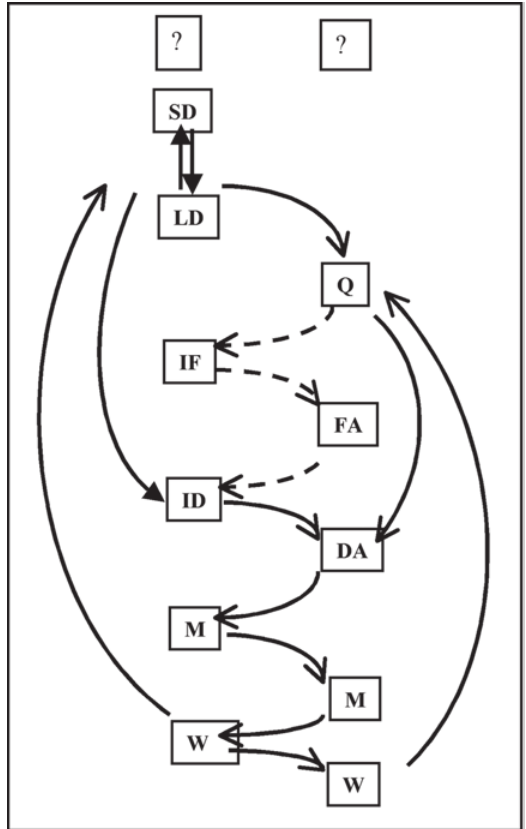
Fig. 3. Flow diagram of behavioral units of transitions of males (a) and females (b) in Austrolebias reicherti . Thickness of arrows is proportional to frequency of transitions. Abbrevia- tions of units shown in Table